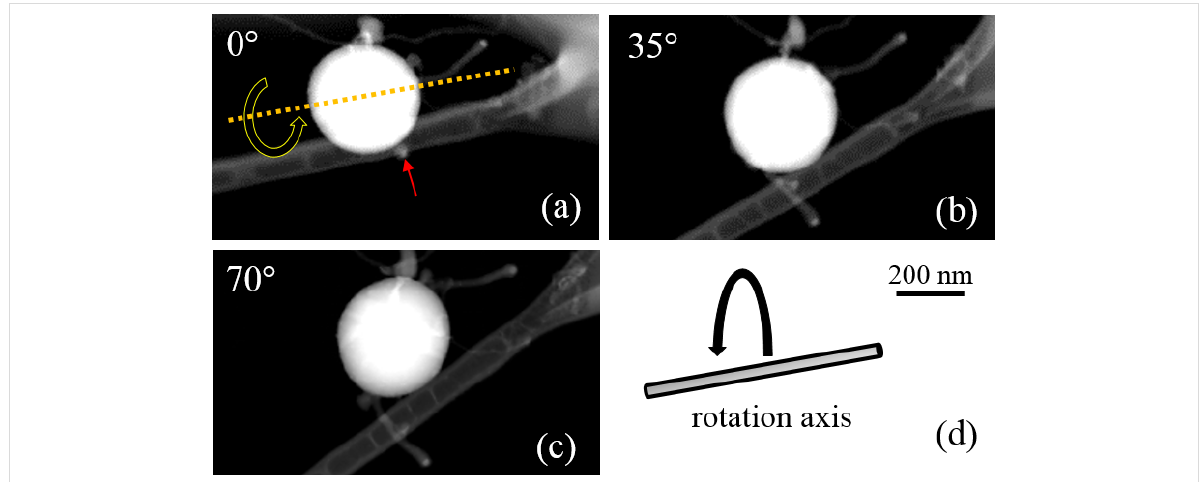
Figure 2: HAADF-STEM micrographs of a SiNS with two connected SiNWs, acquired at (a) 0°, (b) 35° and (c) 70° with respect to the rotation axis shown in (d), which corresponds to the axis of one of the two SiNWs, as indicated by the yellow dashed line in (a). The other SiNW, indicated by the red arrow in (a), is not visible at a rotation angle of 0°, but becomes evident after rotation of the sample (b and c).